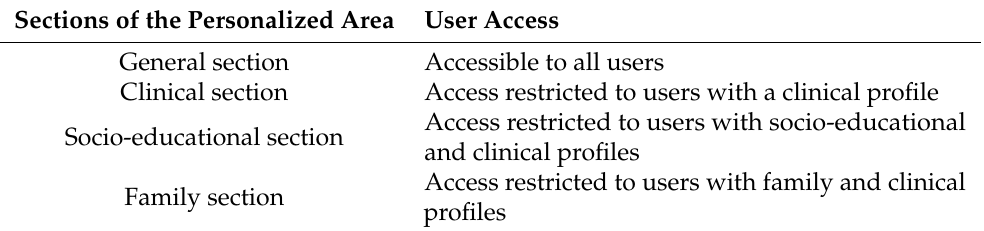
Table 2. An overview of the different access levels of the Personalized Area based on the profiles. The table shows which sections were available based on the user